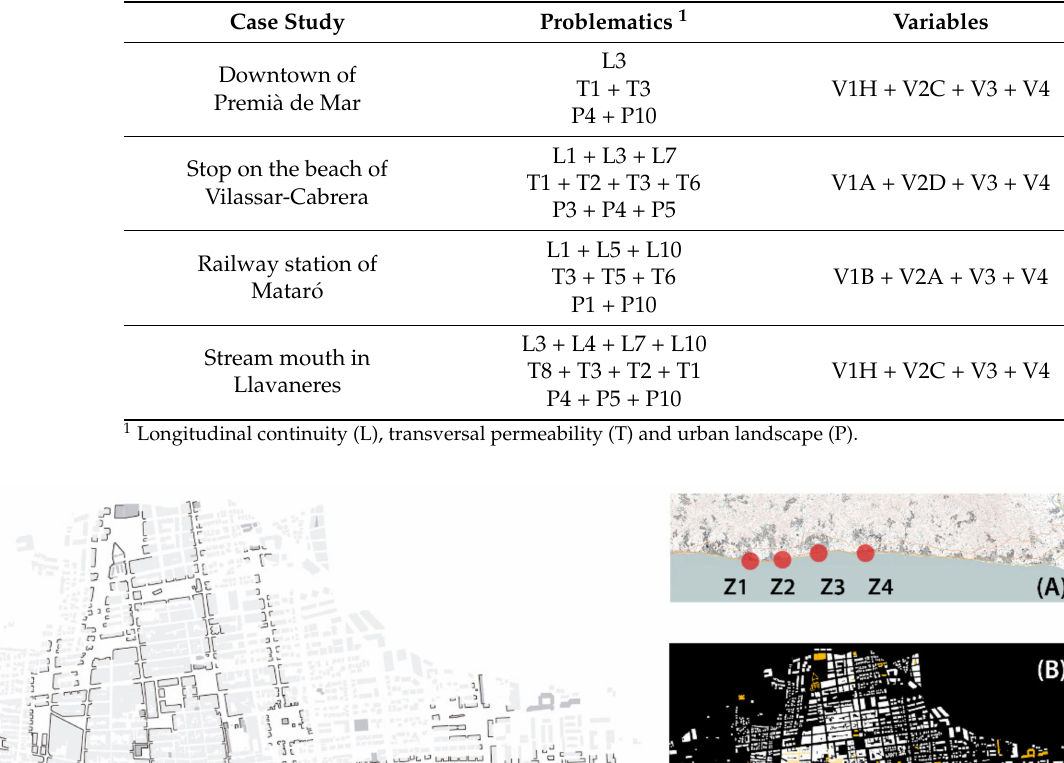
Table 4. Case study selection with identification of problematics, research lines and variables.